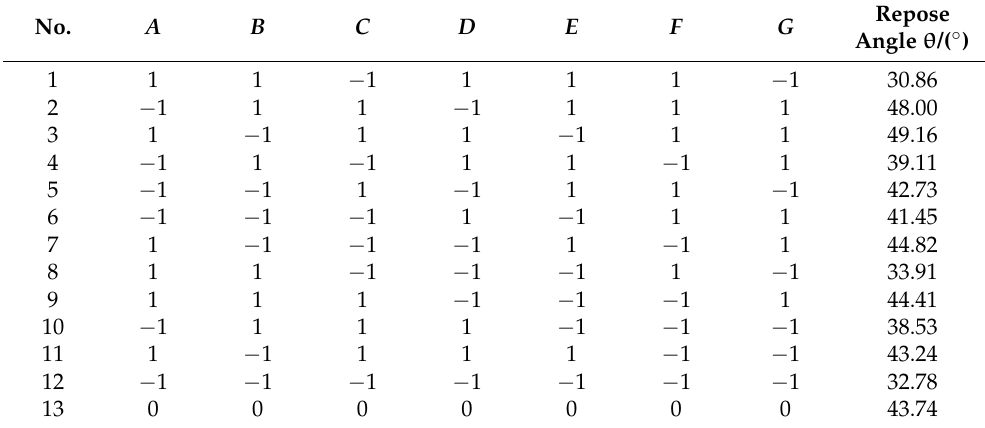
Table 6. Plackett–Burman trial design and